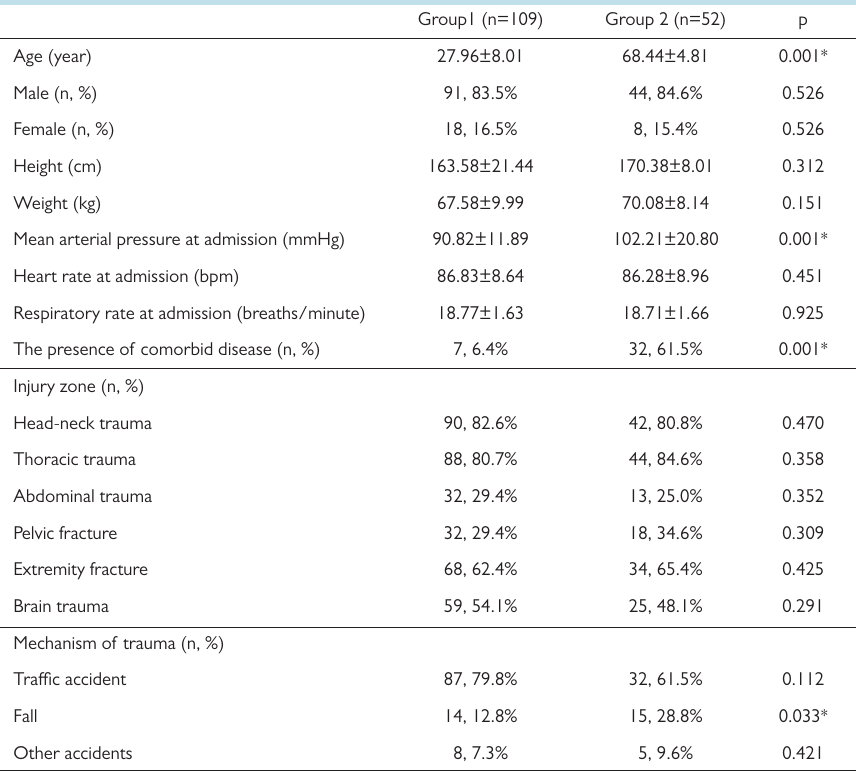
Table 1. Patients’ demographic and clinical